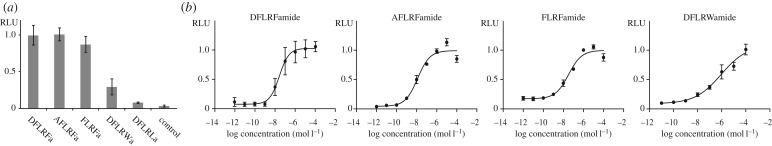
Luminescence response of T. transversa FLRFamide receptor expressing CHO-K1 cells to different peptides. (a) Relative luminescence of T. transversa FLRFamide receptor expressing cells after exposure to different peptides with a fixed concentration of 1 µmol l−1. (b) Dose–response curves of T. transversa FLRFamide receptor expressing cells to different concentrations of DFLRFamide, AFLRFamide, FLRFamide and DFLRWamide. Luminescence values are given relative to maximum luminescence (max = 1). RLU relative luminescence.